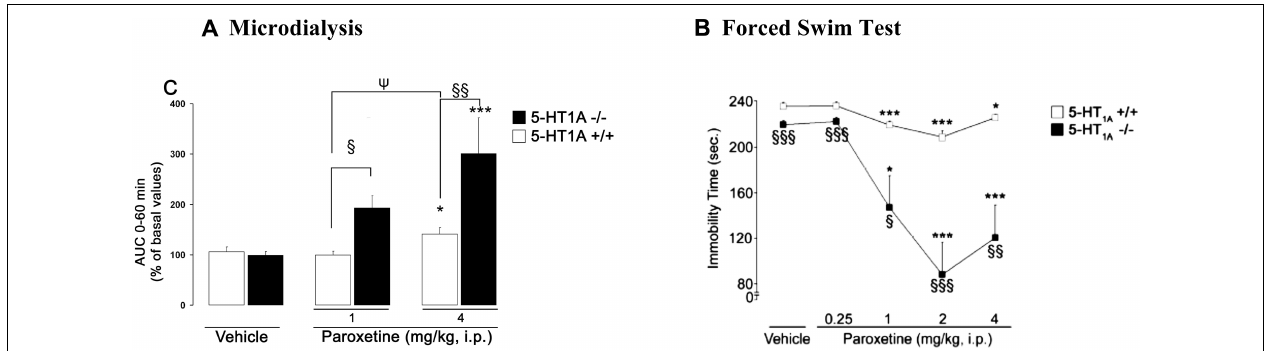
effect of paroxetine on dialysate 5-HText, i.e., 30 min after its administration (from Guilloux etal., 2006). (A) * p < 0.05; *** p < 0.001 when compared to